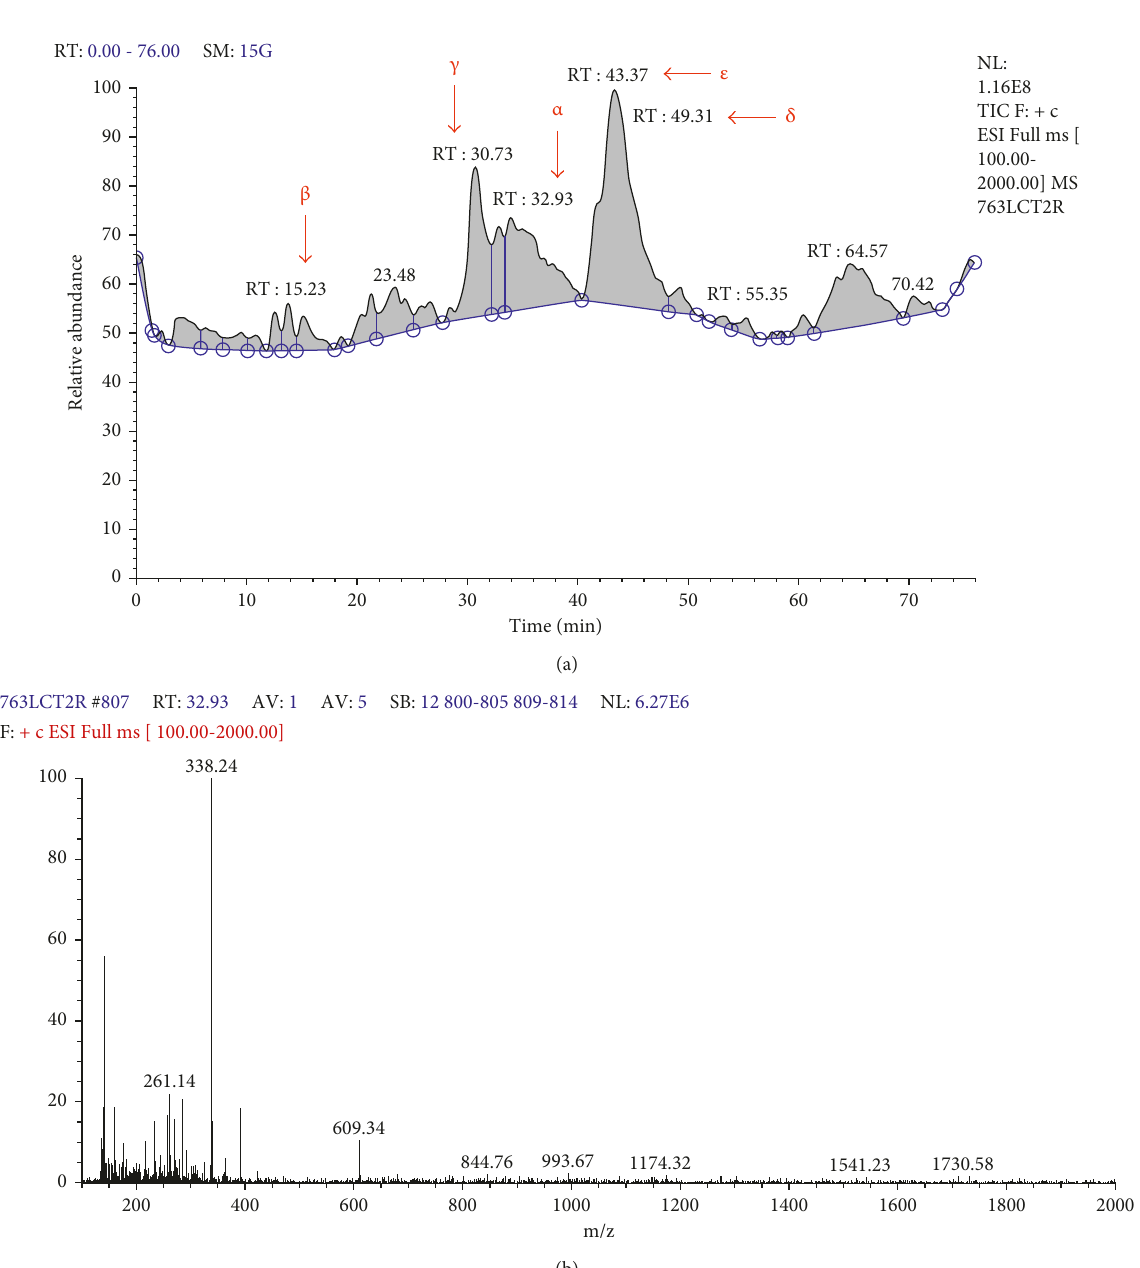
Figure 3: Chemical composition of the ethanol extract of Berberis vulgaris . (a) Ethanol extract’s chromatogram. (b) Example of the mass spectra of molecule α of Berberis vulgaris ethanol extract. The molecules are presented as peaks characterised by mass/charge ( m/z ) ratio and retention